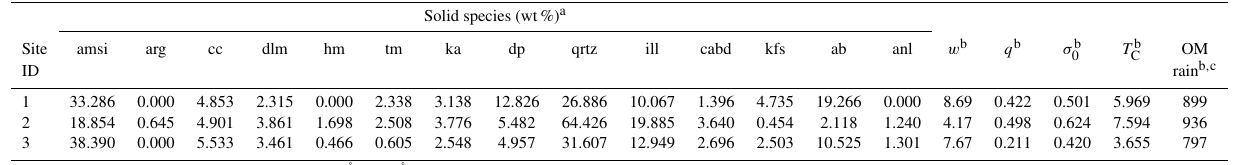
Table 8. Boundary conditions for natural weathering sites.